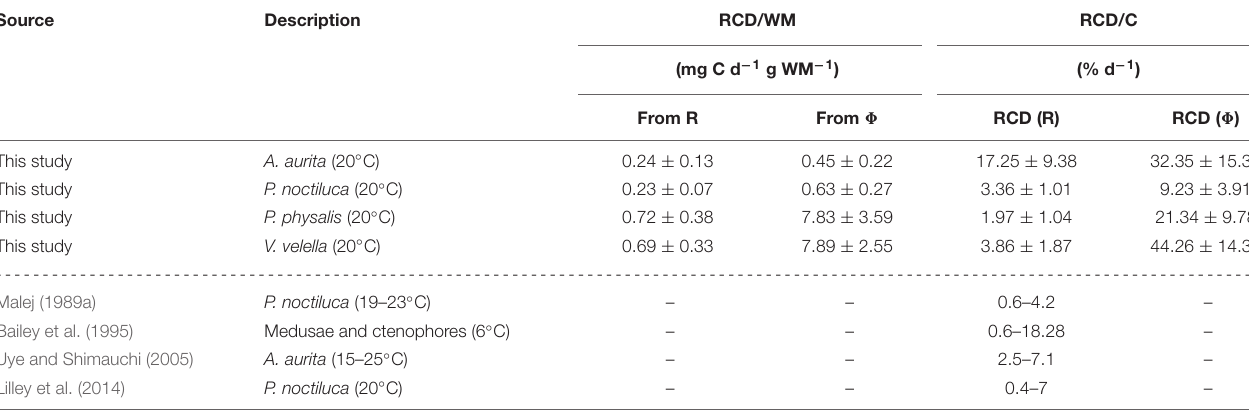
TABLE 3 | Compilation of the RCD (mean ± SD) for our four species of planktonic cnidarians normalized by wet mass (WM) and by carbon content (C).